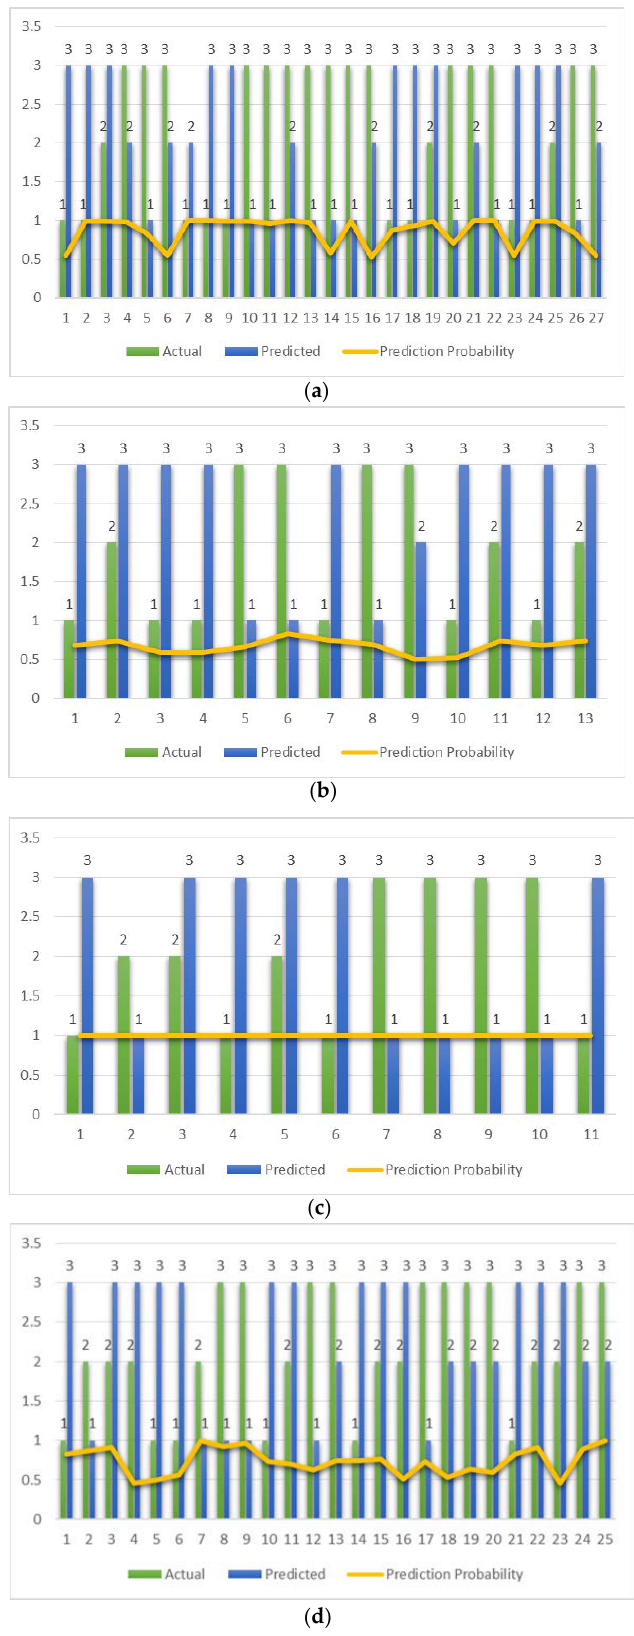
Figure 5. Data points where actual and predicted classifications differ for each of the classifiers. The prediction probability is shown as a yellow